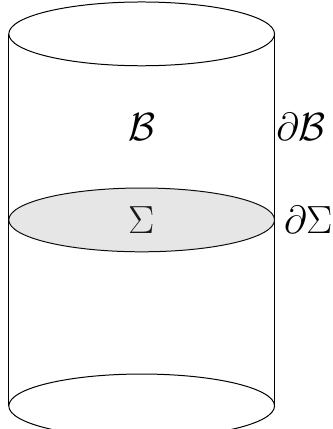
Figure 6 . A Cauchy surface ∂ Σ of the boundary spacetime ∂ B is shown. The field theory state ψ [ { χ } ] lives on ∂ Σ . A slice Σ whose boundary is ∂ Σ is also shown. The WDW-state Ψ[ g ] , dual to ψ [ { χ } ] , lives on Σ